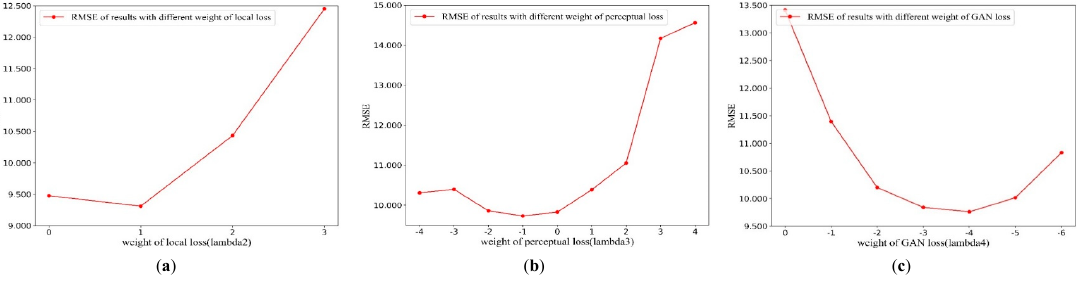
Figure 11. Sensibility of the parameters: ( a ) λ 2 ; ( b ) λ 3 ( c ) λ 4 .